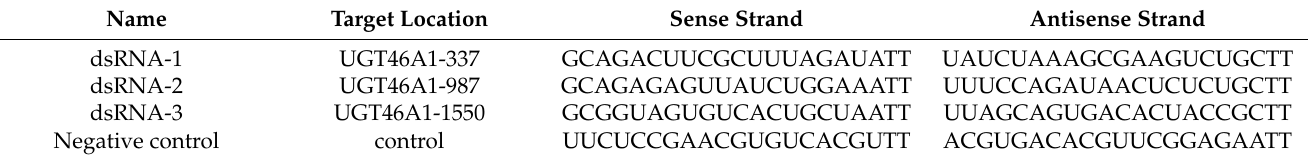
Table 2. DsRNA sequence